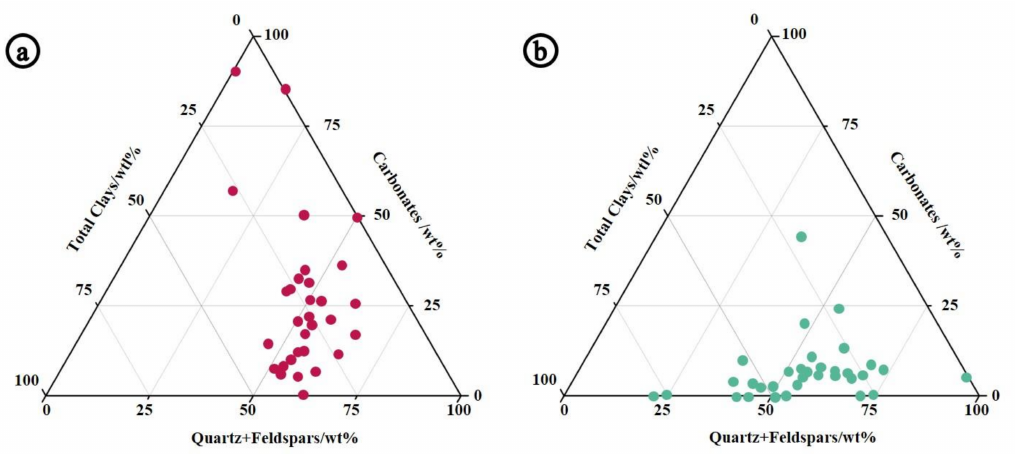
Figure 4. Mineralogical ternary plot for shale samples: ( a ) samples of lower Cambrian shale are represented by the red dots and ( b ) samples of lower Silurian shale are represented by the green